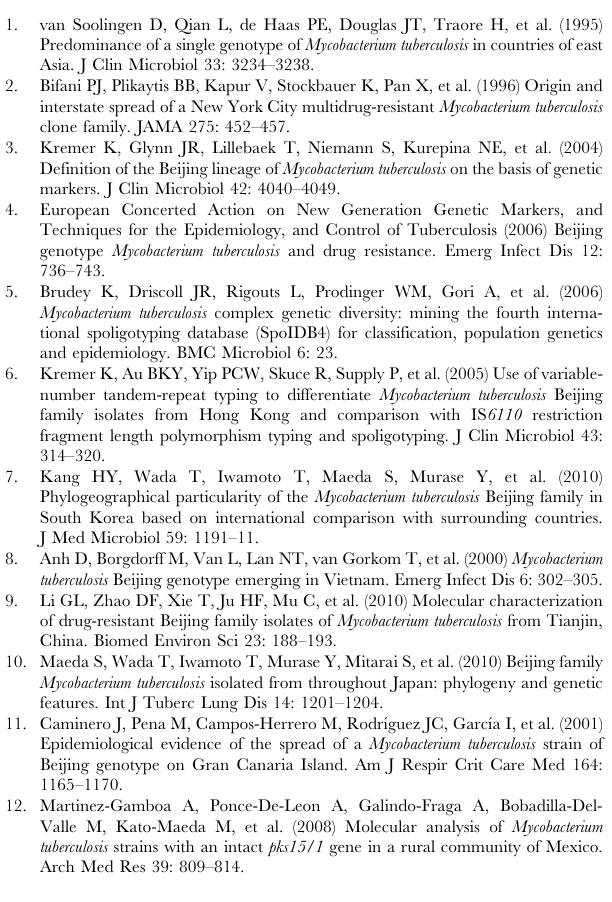
Table S3 Associations between M. tuberculosis lineage and disease presentation among TB patients aged 15–64 years at diagnosis and with known HIV